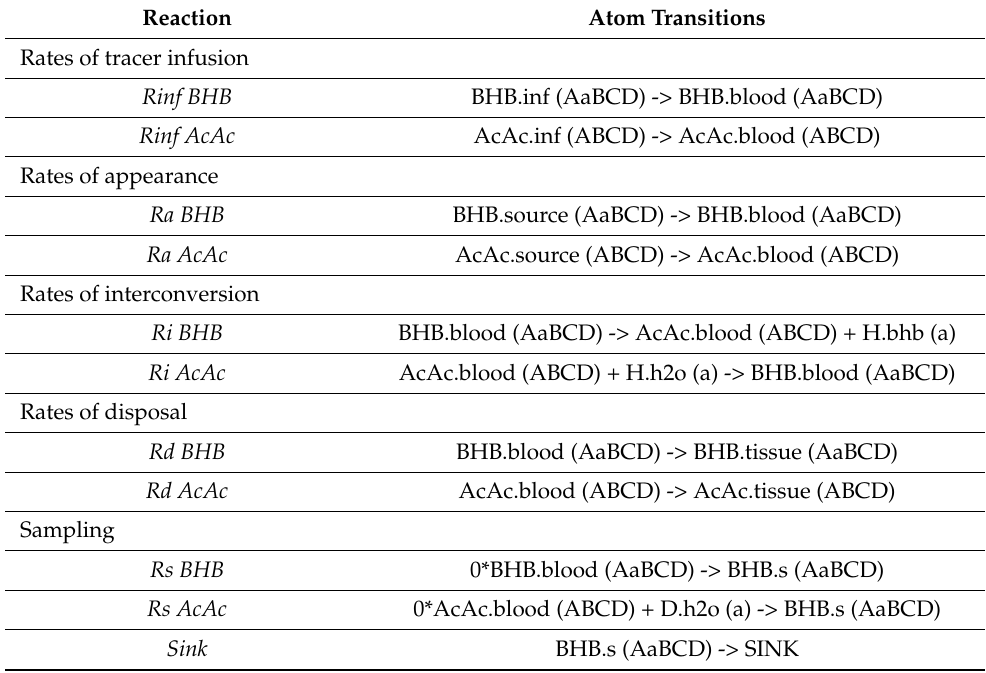
Table 1. Atom transitions used in the MFA implementation of a two-pool model of ketogenesis. Atom transitions are denoted by letters: capital for carbon atoms and lower case for